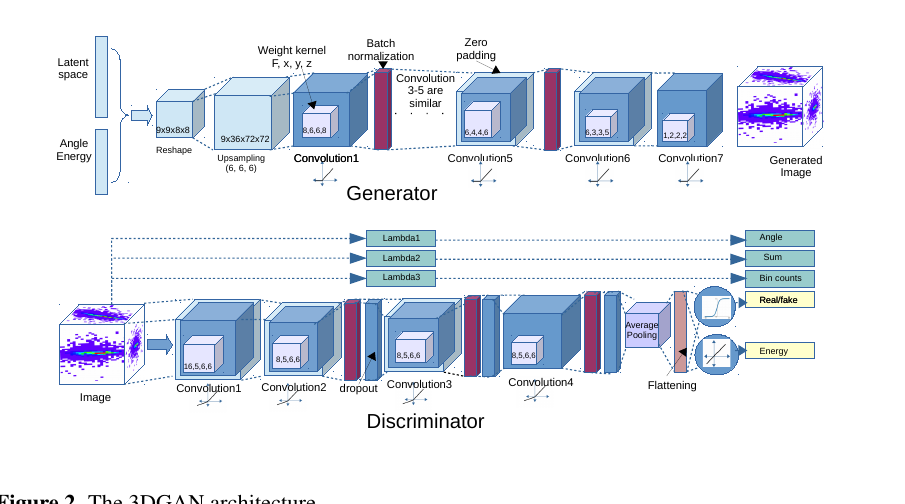
Figure 2. The 3DGAN architecture